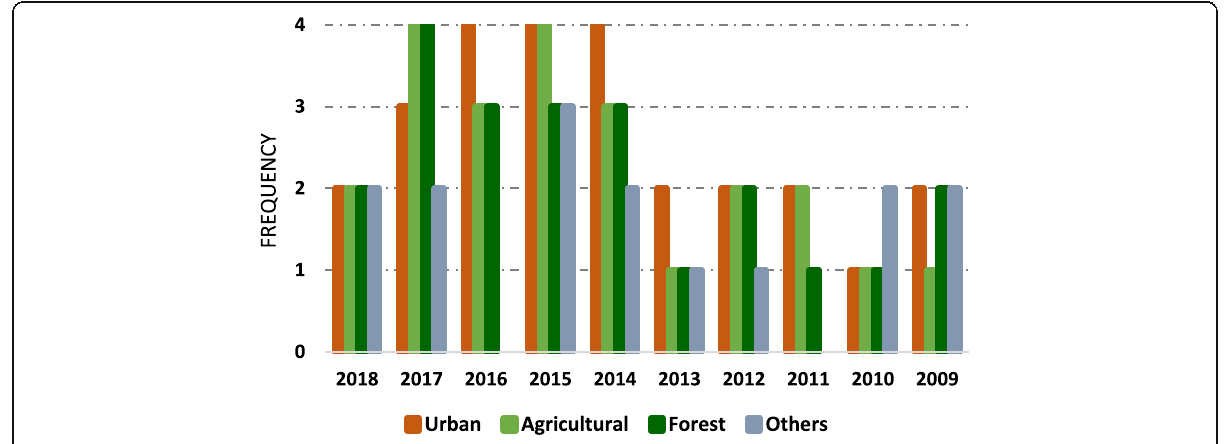
Fig. 3 Frequency of land use attributes used in different studies in